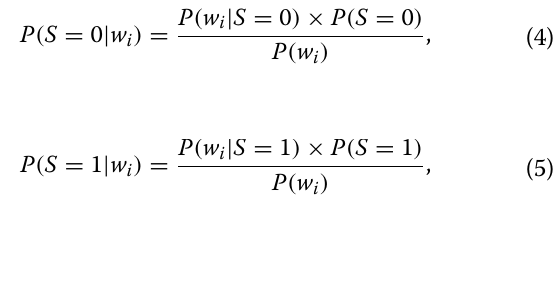
Fig. 5, when the width of a wide task is 50 ability that it is a small task is 85%.